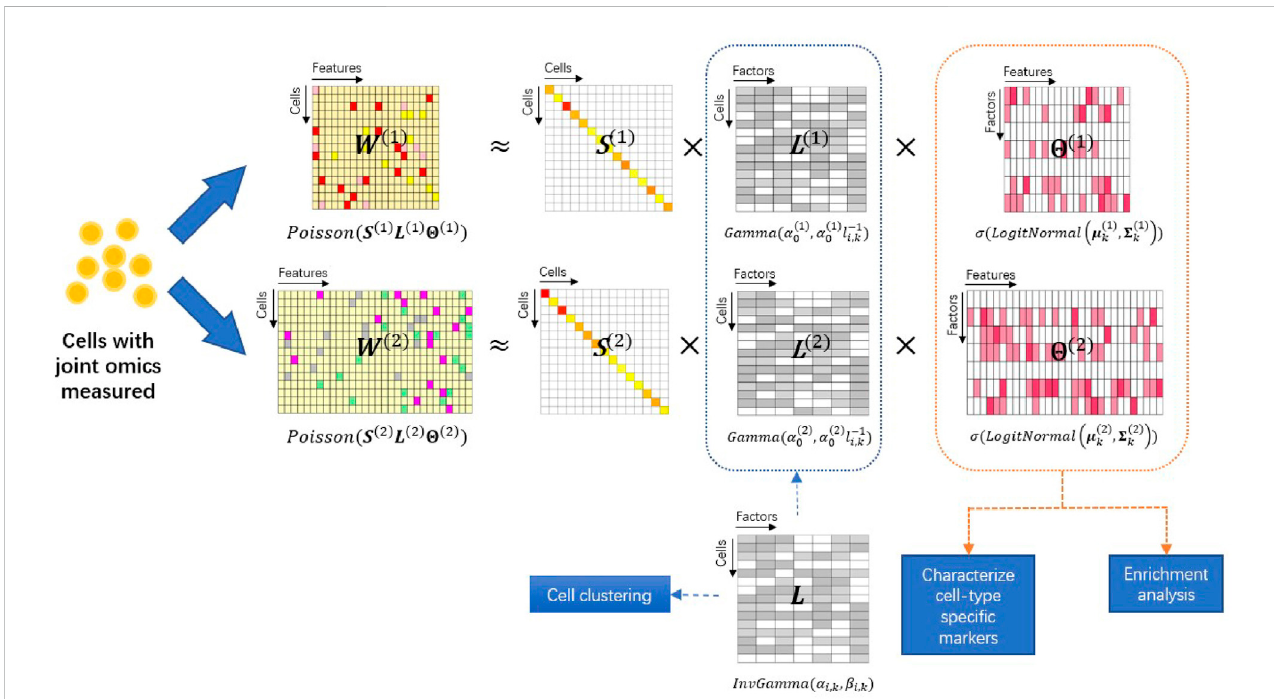
FIGURE 1 Overview of the iPoLNG model. The input consists of two data modalities measuring different aspects of biological pro fi les in the same set of cells. Each data modality W ( m ) is approximated by the matrix product of a diagonal matrix S ( m ) that takes into account the cell sequencing depth, a feature loading matrix Θ ( m ) and a cell loading matrix L ( m ) for m = 1, 2. The feature loading matrices can characterize cell-type speci fi c markers and facilitate functional pathway enrichment analysis. The cell loading matrices have different variances due to the levels of noise across different data modalities, but share the same mean, L , which represents the low-dimensional cell embedding and facilitates cell